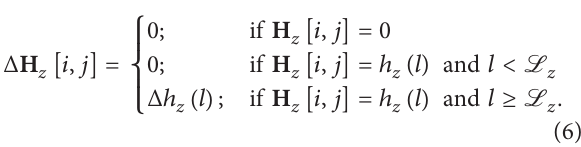
Figure 5: An interference-prone breast channel where two agent- loaded MTB swarms are present in the cluttered breast with tissue inhomogeneities. A radar system containing multiple spatially diverse monostatic antenna elements is deployed for tracking the